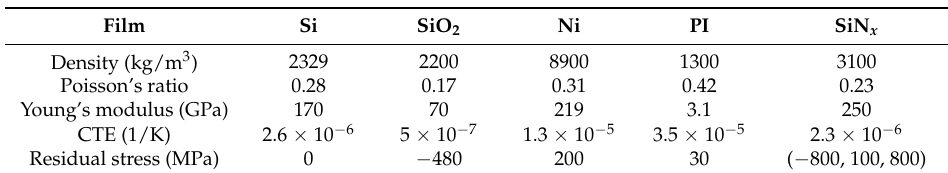
Table 1. The basic material properties in the simulation process. CTE: Coefficient of thermal expansion; PI: Polyimide.